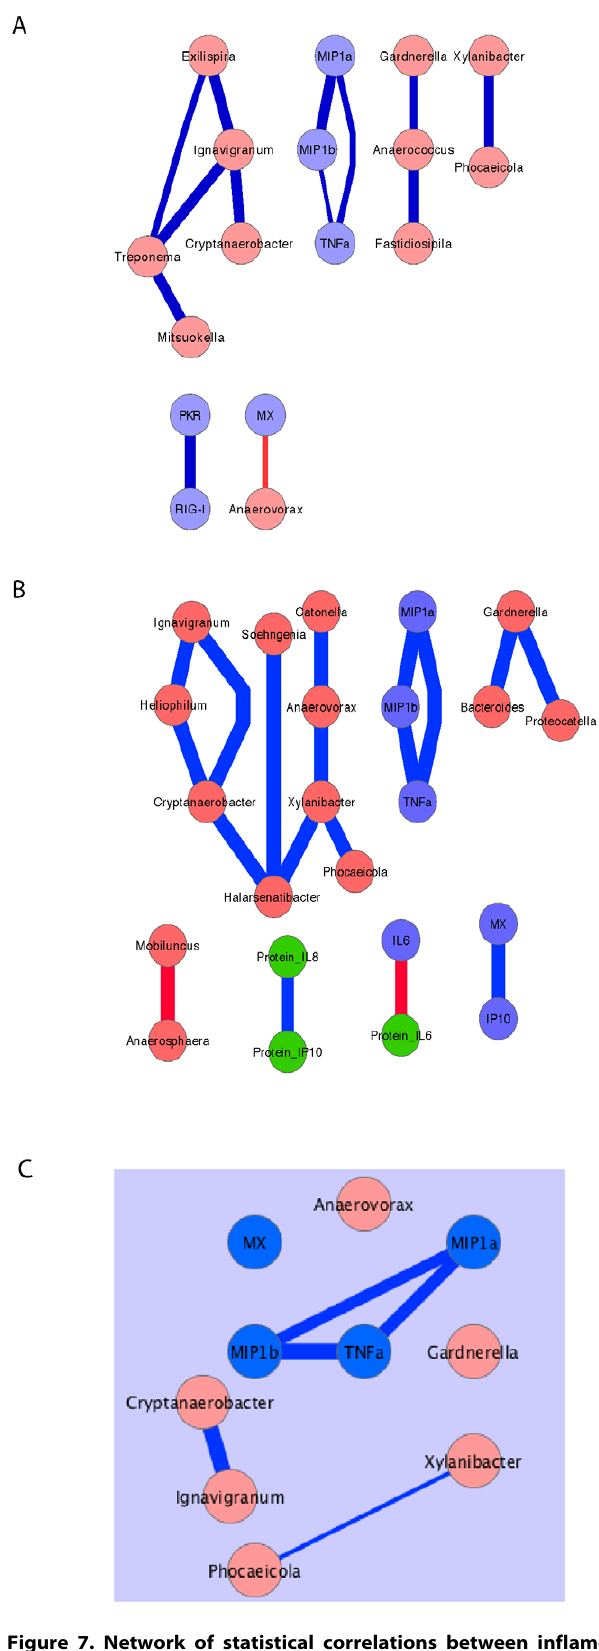
Figure 7. Network of statistical correlations between inflam- matory mediators and microbiota. After unbiased analysis